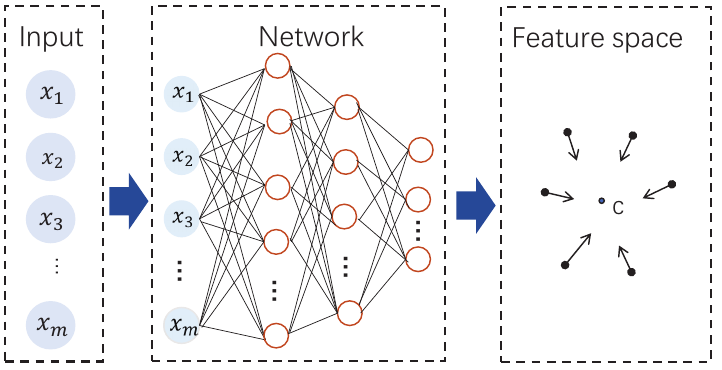
Figure 2. Deep SVDD